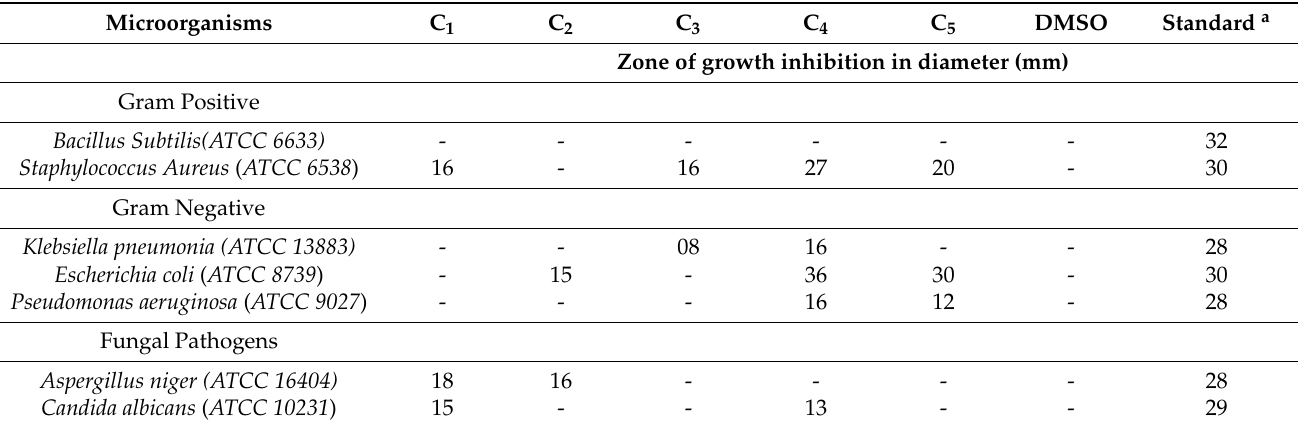
Table 6. Antibacterial and Antifungal activities of Co(II) complexes.